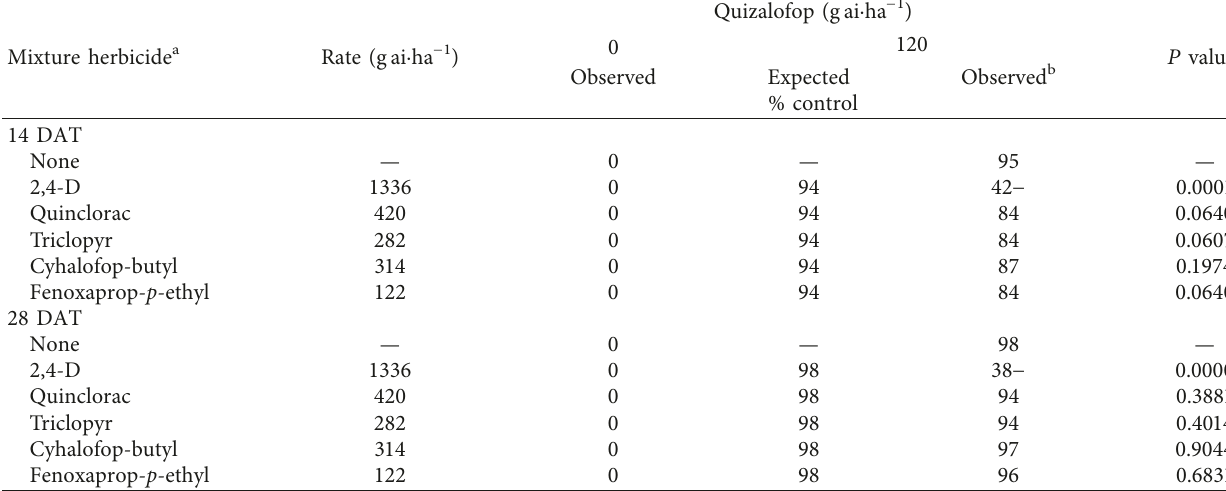
Table 5: CL-111 IR rice control with quizalofop- p -ethyl mixed with different synthetic auxin or ACCase-inhibiting herbicides in 2015 and 2016 crop seasons. Mixture herbicide